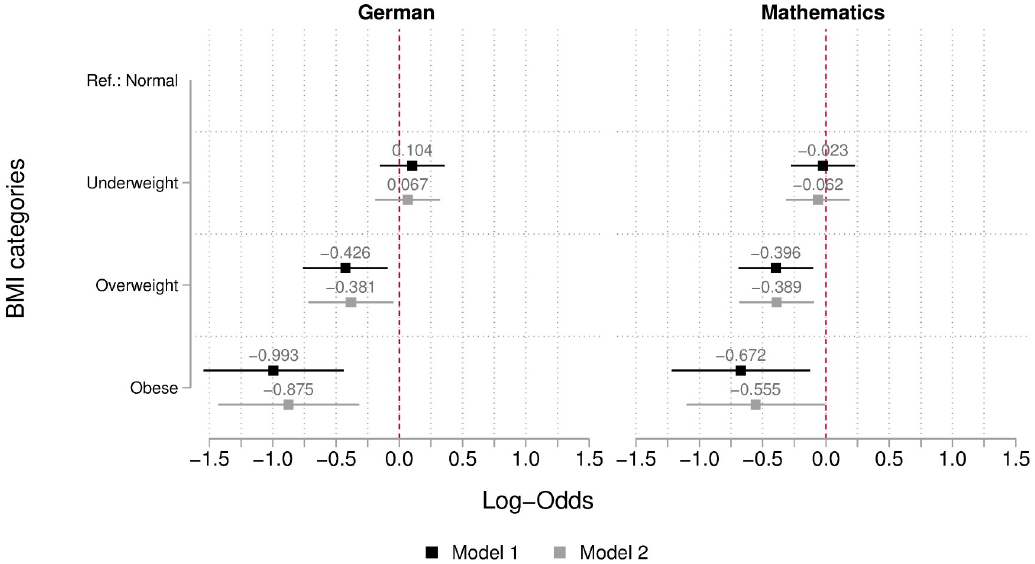
Fig 2. Teachers’ grading bias (measured in log-odds) according to students’ BMI. The graph shows log-odds ratios from the 3-level hierarchical ordered logit model on mathematics grades (left) and German (right). Bars represent 95% confidence intervals. Model 1 adjusts for students’ competence level and socio-demographic variables, while model 2 also includes students’ psychological traits, and school-related attitudes and behavior. N = 3,754. Analysis conducted on 50 multiply imputed datasets.